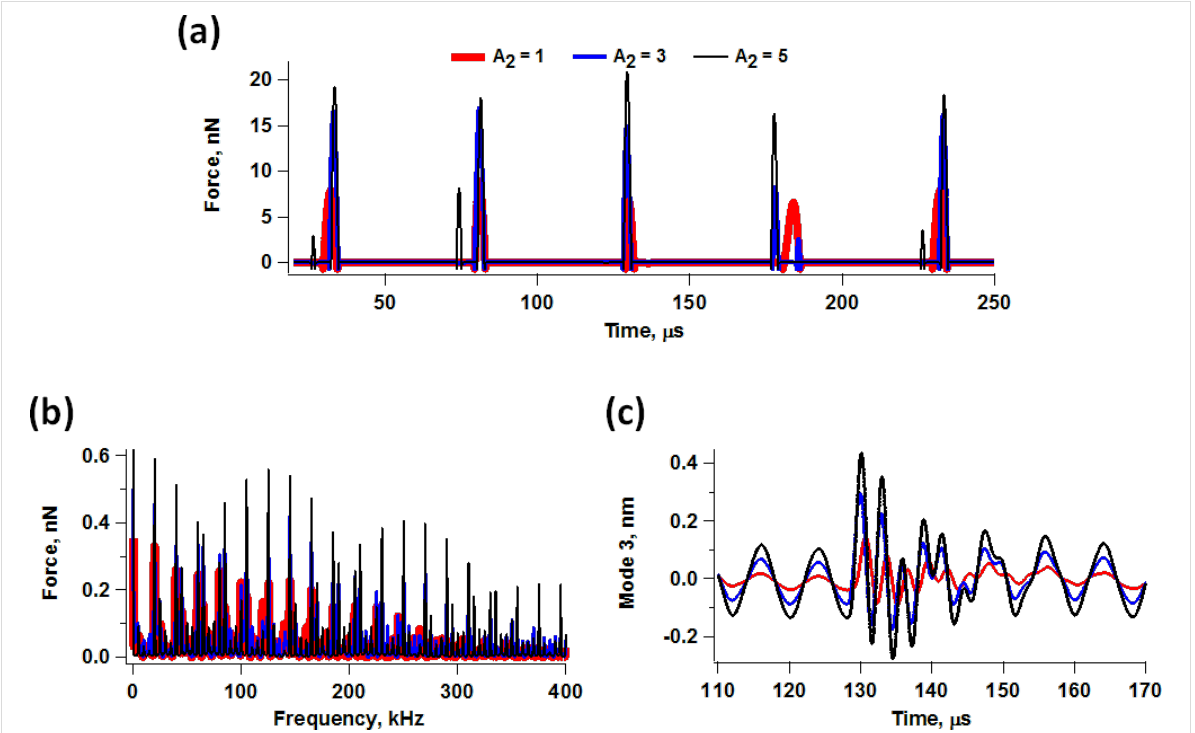
Figure 8: Illustration of the force trajectory of five successive tip–sample impacts for bimodal AFM conditions similar to those used to construct Figure 2, for three different second mode amplitudes ranging from 1 nm to 5 nm (a) along with the corresponding force spectra (b) and typical third eigenmode momentary excitation responses (c).